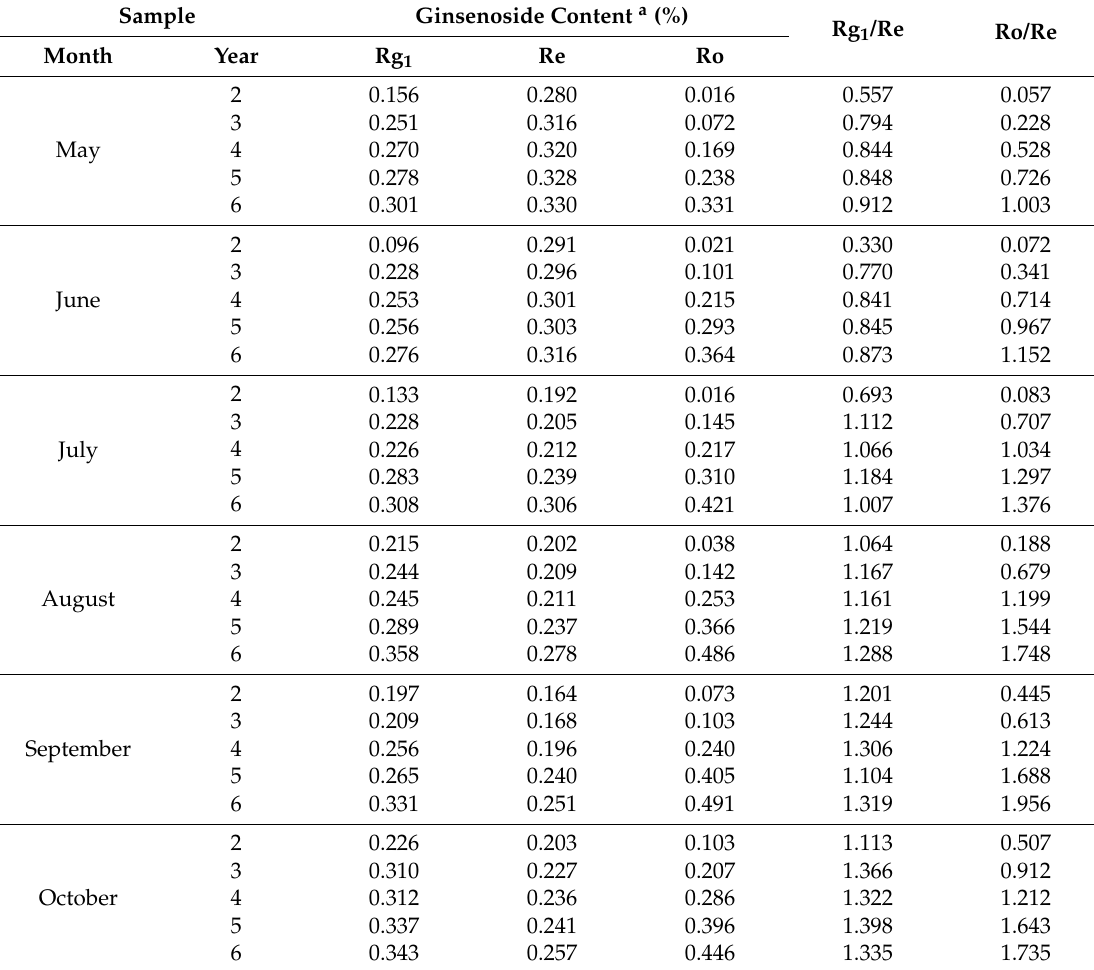
Table 1. Ginsenoside content and ratio in different cultivation age and month of P.